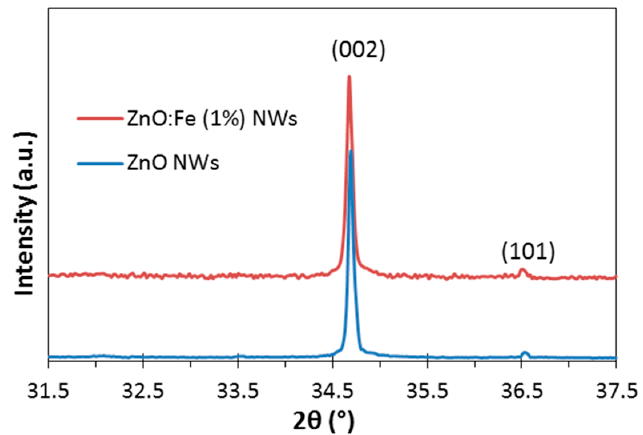
Figure 3. X-ray diffraction (XRD) spectra of the nanowire arrays obtained by hydrothermal method both for undoped ZnO NWs and 1% Fe-doped ZnO NWs, respectively.